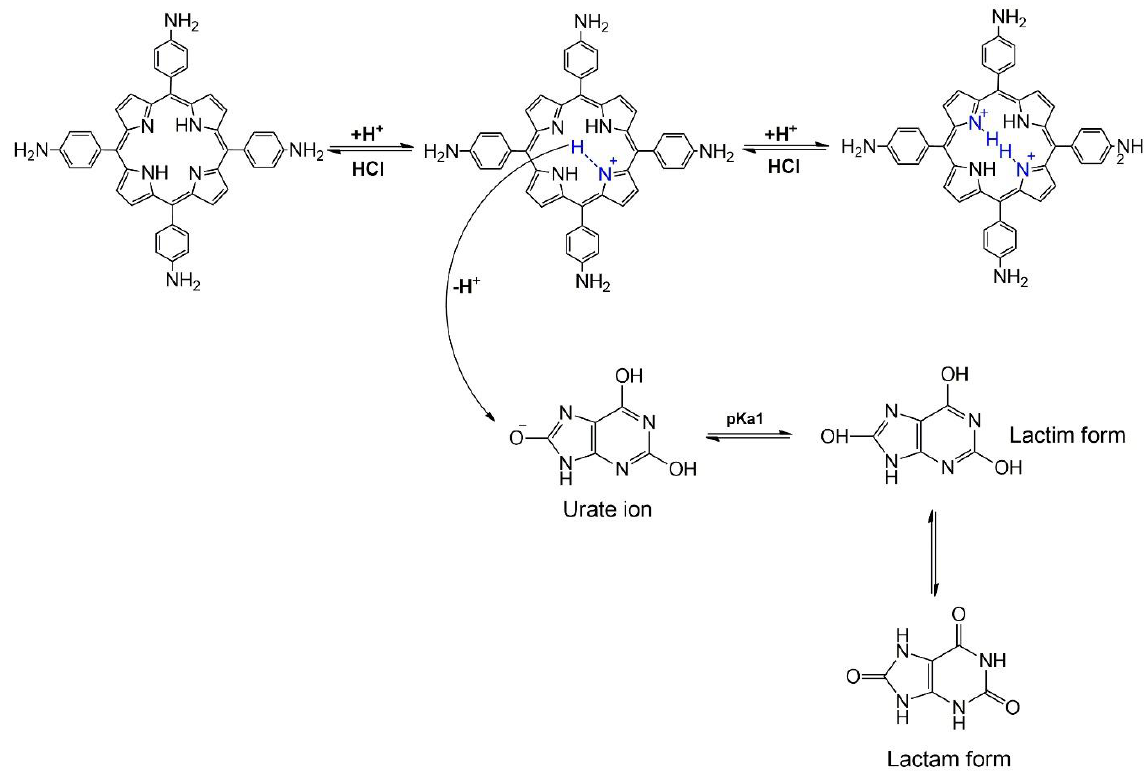
Figure 15. The mechanism ofuric acid detection based on a proton transfer from the protonated TAmPP porphyrin toward the urate ion, with regeneration of lactim form.